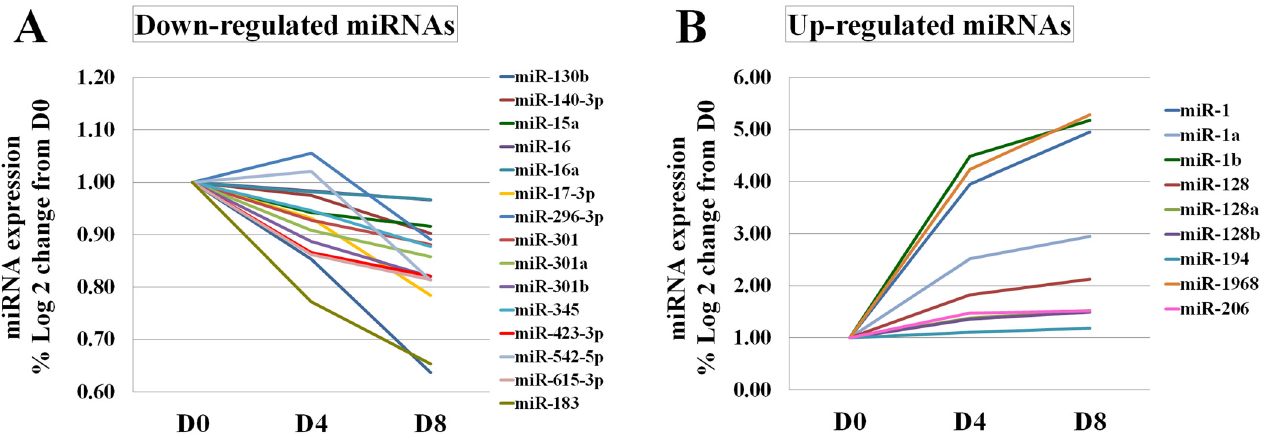
Fig 4. Alteration of miRNA expression in C2C12 myoblasts post-myotube induction. (A) 15 down-regulated miRNAs that were negatively correlated with the ATP level (correlation coefficient, r = -0.67 to -0.83, P < 0.05). (B) 9 up-regulated miRNAs that were positively correlated with the ATP level (r = 0.67 to 0.79, P <